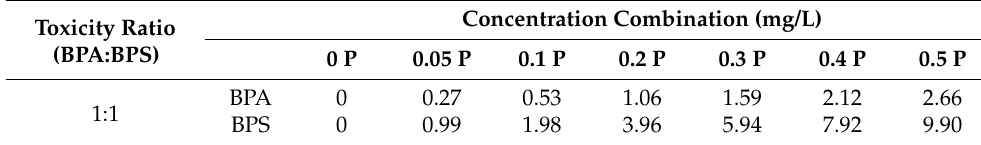
Table 1. Concentration combinations of BPA and BPS under 1:1